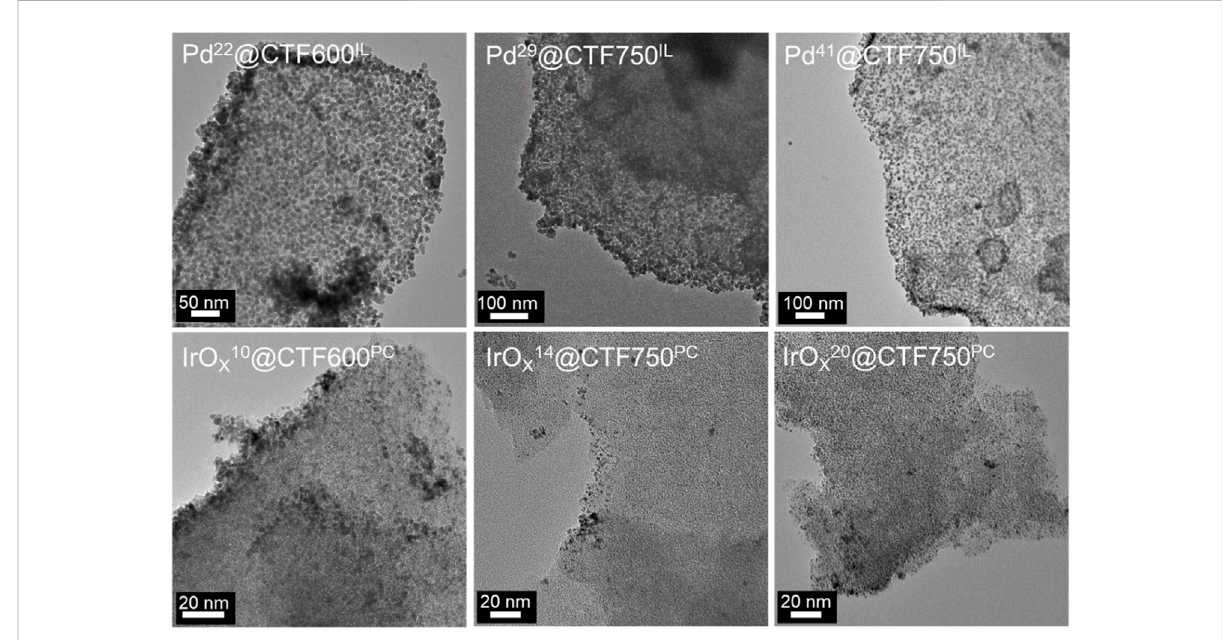
FIGURE 3 TEM images of Pd- and IrO x -NP supported DCP-CTF materials before electrocatalysis.